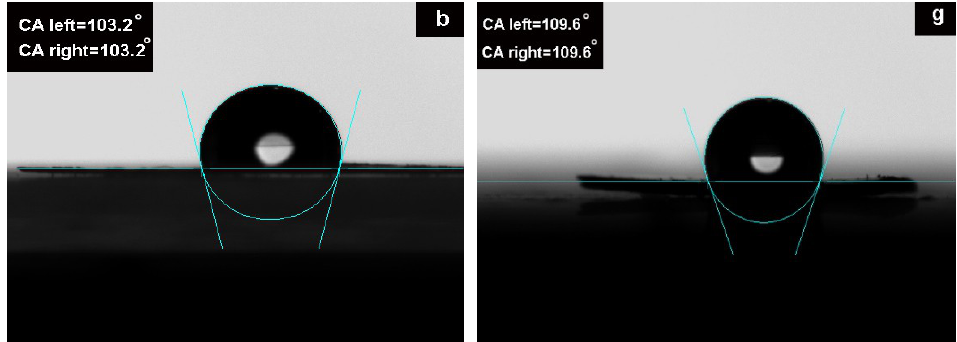
Figure 2. The water contact angle of typical ORGO (( b ) ORGO at 35 °C, 0.5 h; ( g ) ORGO at 80 °C, 5 h).